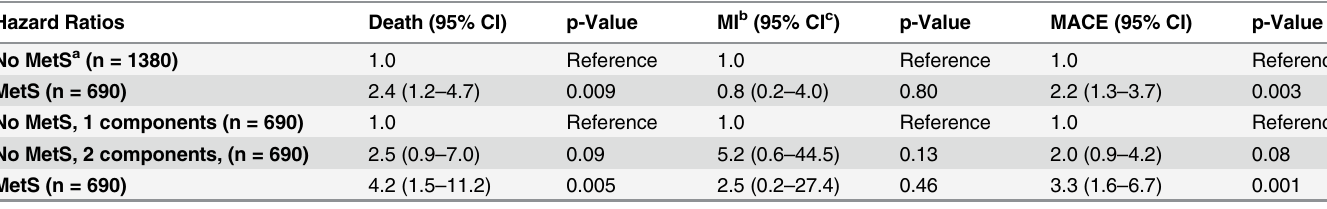
Table 4. Hazards ratios for incident MACE for patients with versus without